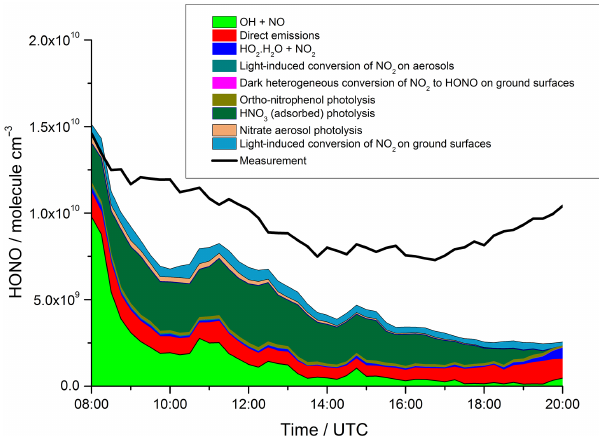
Figure 4. Time series of measured (black) and model calculated (grey) HONO during the IOP. The model was based on the Master Chemical Mechanism (MCM v3.2); see text for details.